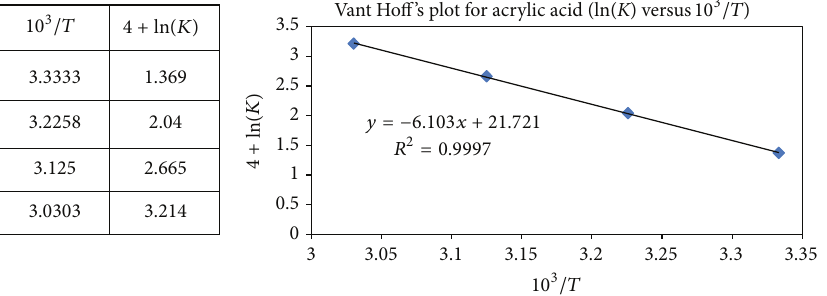
Figure 9: Vant Hoff’s plot of acrylic acid (ln (𝐾) versus 10 3 / 𝑇 ). Kinetic study with [Phen] = 3.75 × 10 −3 moldm −3 [PEG-300] = 6.24 × 10 −1 moldm −3 ; [Fe(III)] = 1.25 × 10 −3 moldm −3